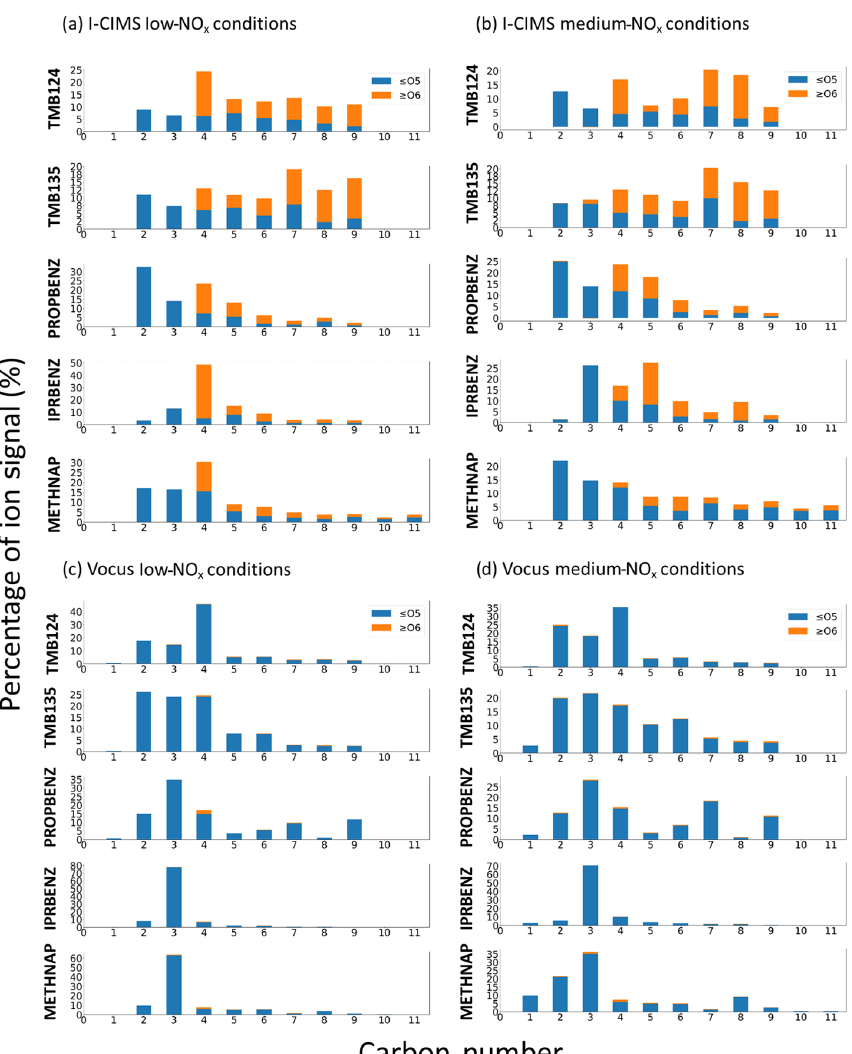
Figure 3. Signal distribution across carbon numbers and coloured by the proportion of HOM signals for (a) I-CIMS particle phase under low- NO x conditions, (b) I-CIMS particle phase under medium-NO x conditions, (c) Vocus gas phase under low-NO x conditions and (d) Vocus gas phase under medium-NO x conditions. Only signal contributions up to the precursor carbon numbers are included, namely C9 for TMB124, TMB135, PROPBENZ and IPRBENZ and C11 for METHNAP, to capture both the ring-retaining and ring scission products for mechanistic discussions below. There is very little signal above C9 for the C9-aromatic